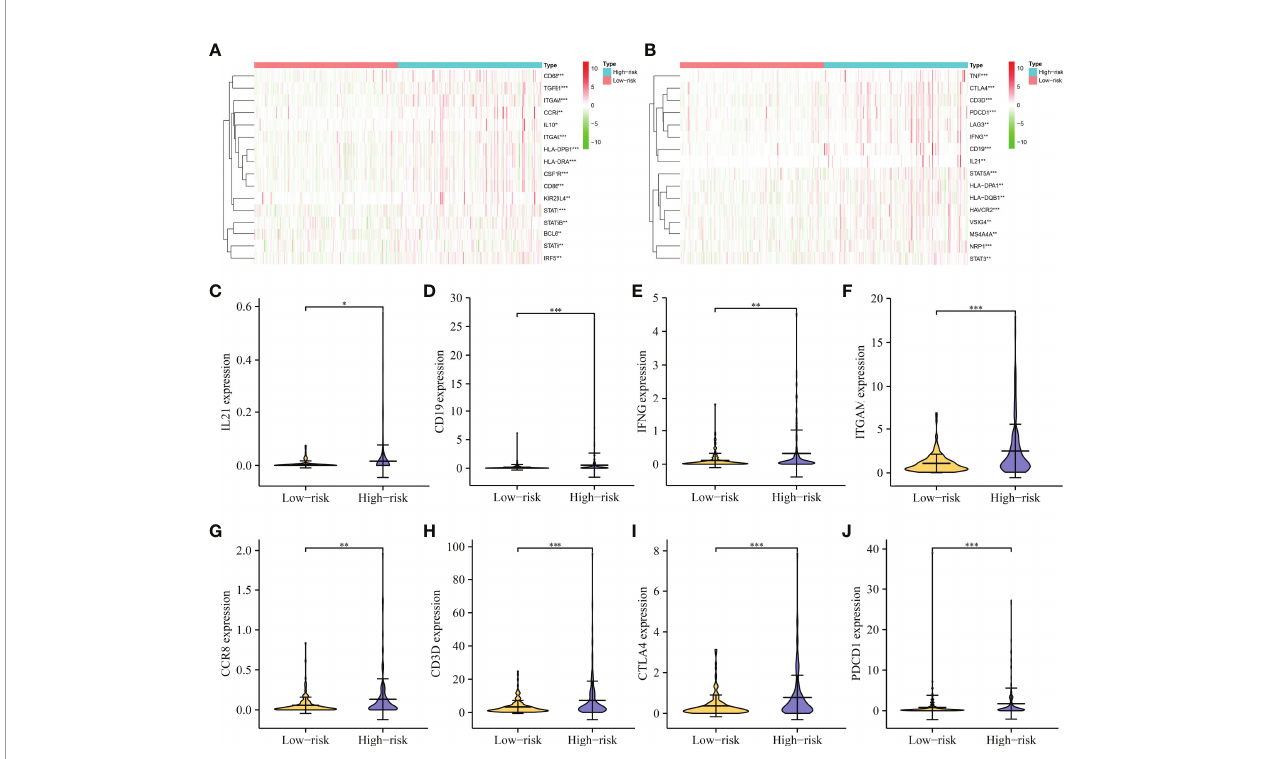
FIGURE 11 | The expression levels of immune-in fi ltrating cell markers in high- and low-risk groups. (A, B) A heatmap showing the expression pattern of immune genes in HCC tissues. (C – J) Violin showing the expression of IL21, CD19, IFNG, ITGAM, CCR8, CD3D, CTLA4, and PDCD1 in HCC tissues. HCC, hepatocellular carcinoma; *P < 0.05; **P < 0.01; ***P <